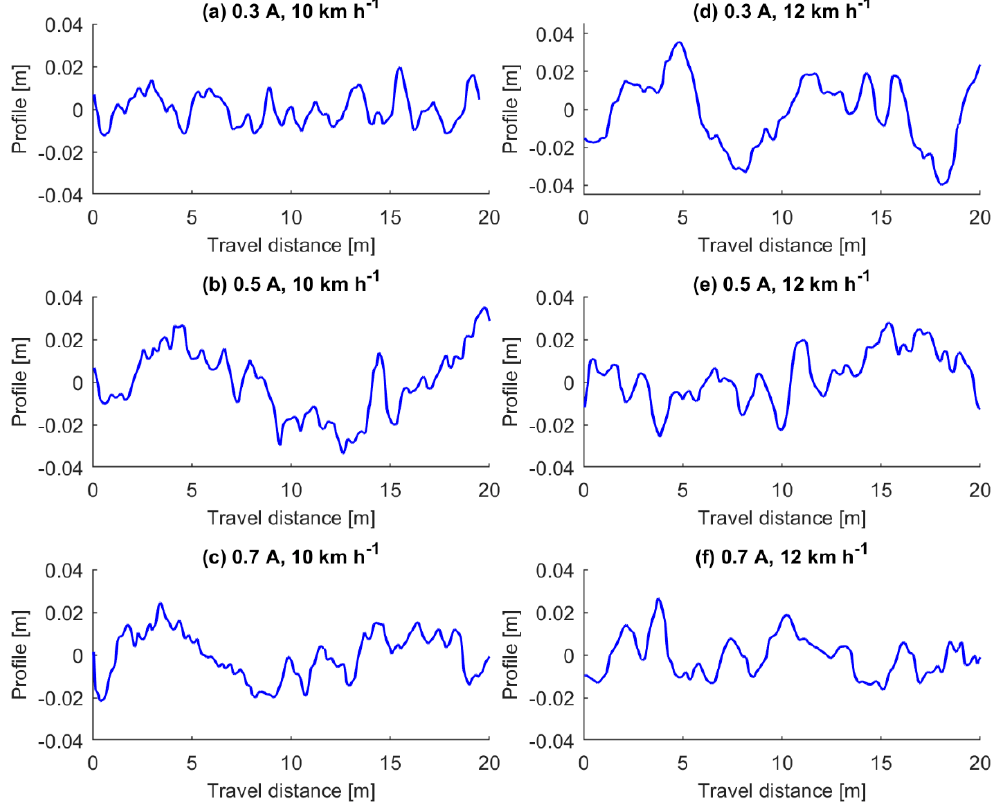
Figure 4. The measured field surface profiles at the speeds of ( a – c ) 10 km h − 1 and ( d – f ) 12 km h − 1 , when the MR damper was supplied with 0.3 A, 0.5 A, and 0.7 A.